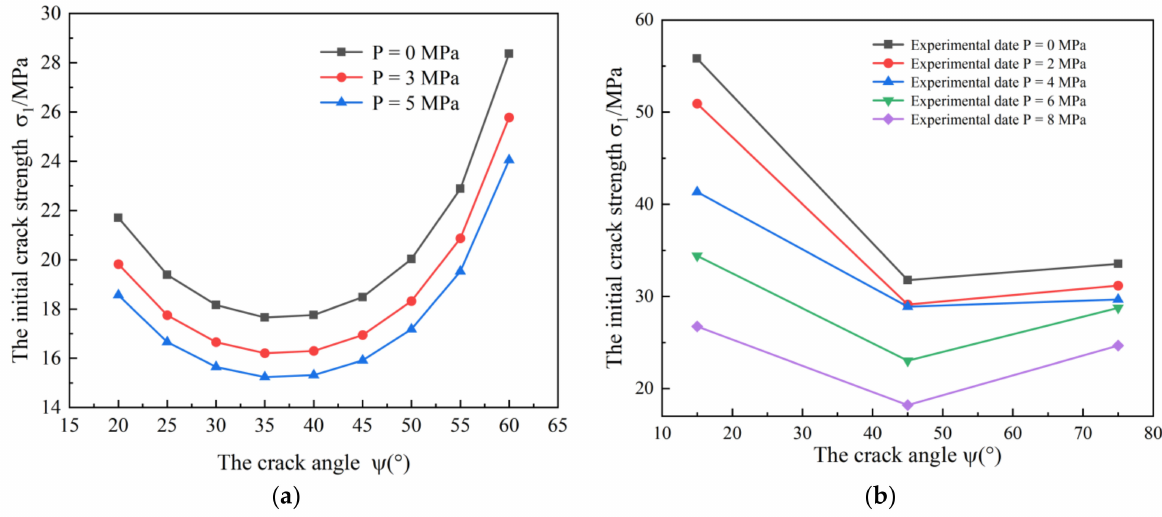
Figure 3. The crack initiation strength under different factors on hydraulic pressure. ( a ) Theoretical data; ( b ) experimental data